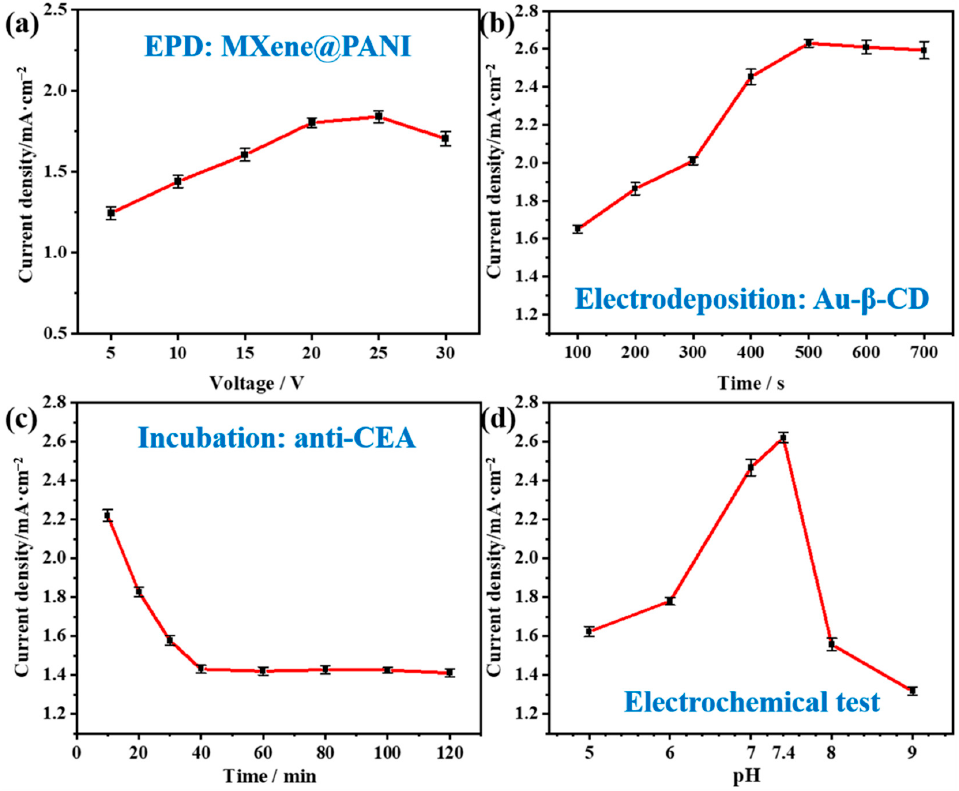
Figure 4. Current response to the variation of ( a ) voltage of EPD process, ( b ) deposition time of electrodeposition process, ( c ) incubation time of anti-CEA, and ( d ) pH of the electrolyte for electrochemical evaluation.